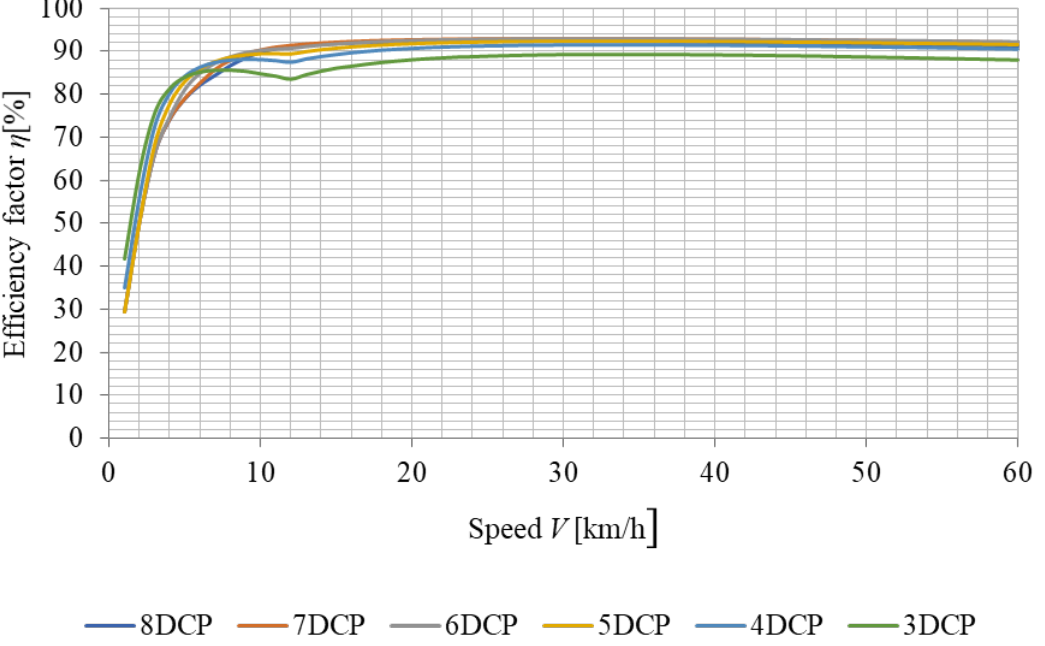
Figure 9. Dependence of efficiency on speed for different positions of the driver’s controller (diesel ChME3 locomotive by traction asynchronous electric motors) (3DCP-8DCP are position numbers of the driver’s controller from 3 to 8, respectively). Source: own